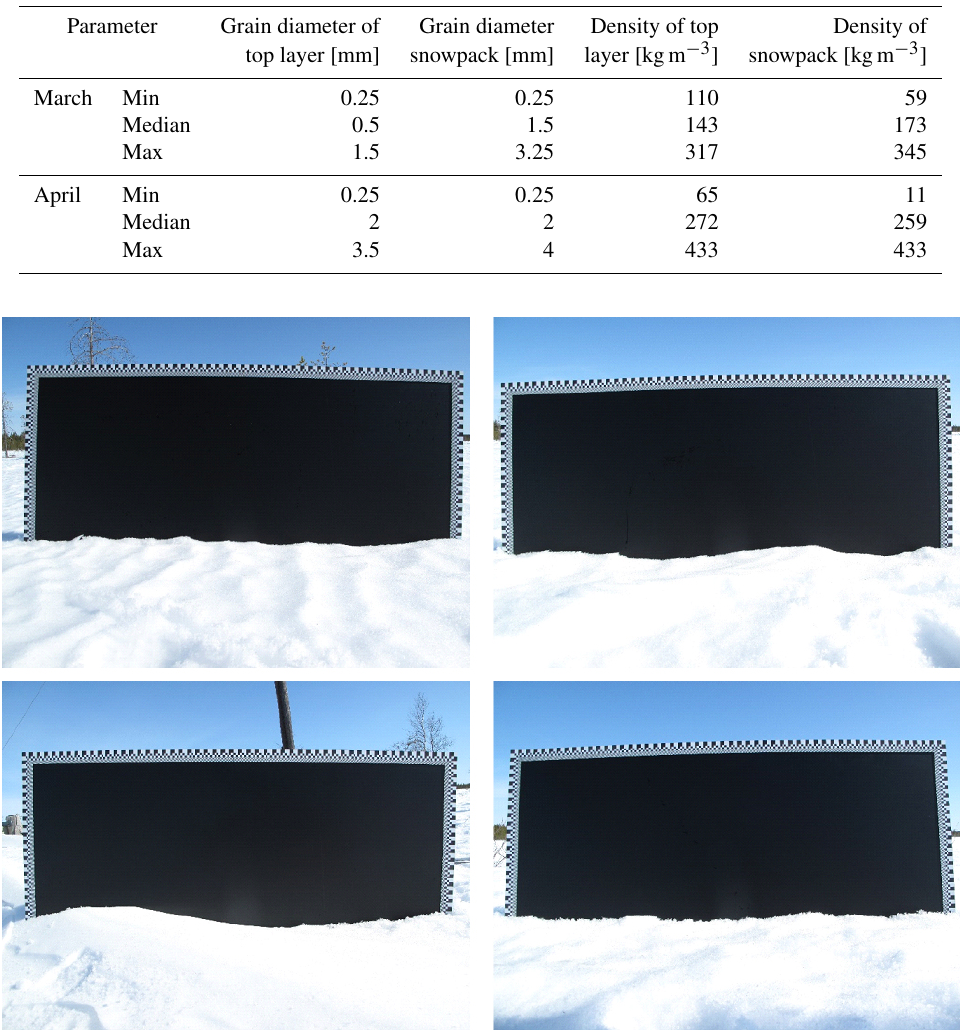
Figure 2. Examples of surface roughness of snow at Mantovaaranaapa on 22 April 2009. The black background of the plate is 1m wide.